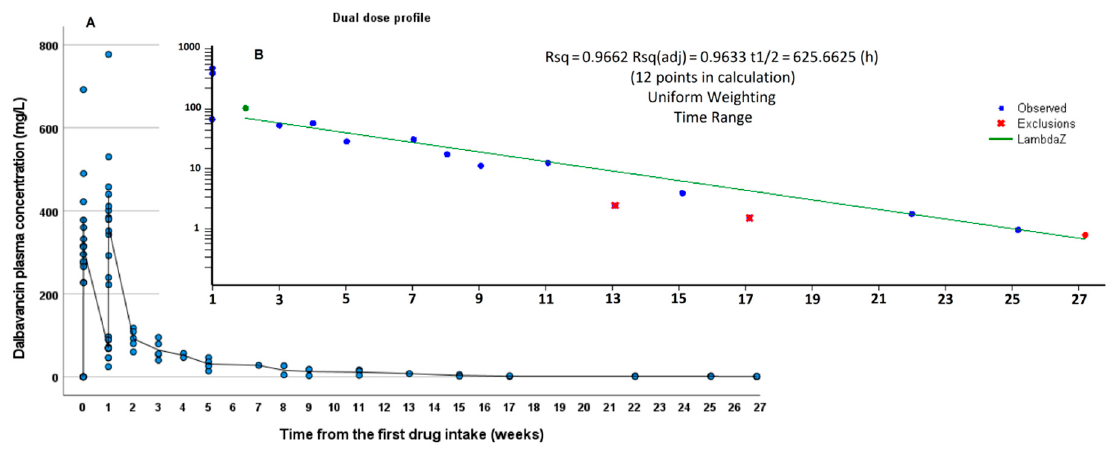
Figure 2. Summary of the mean DBV PK data from the full PK follow-up for the dual 1500 mg infusion group (4 patients) in linear-linear scale ( A ) and in log-linear scale ( B , limited to the second dose administration). The blue line indicates the time range for the estimation of terminal λ z.